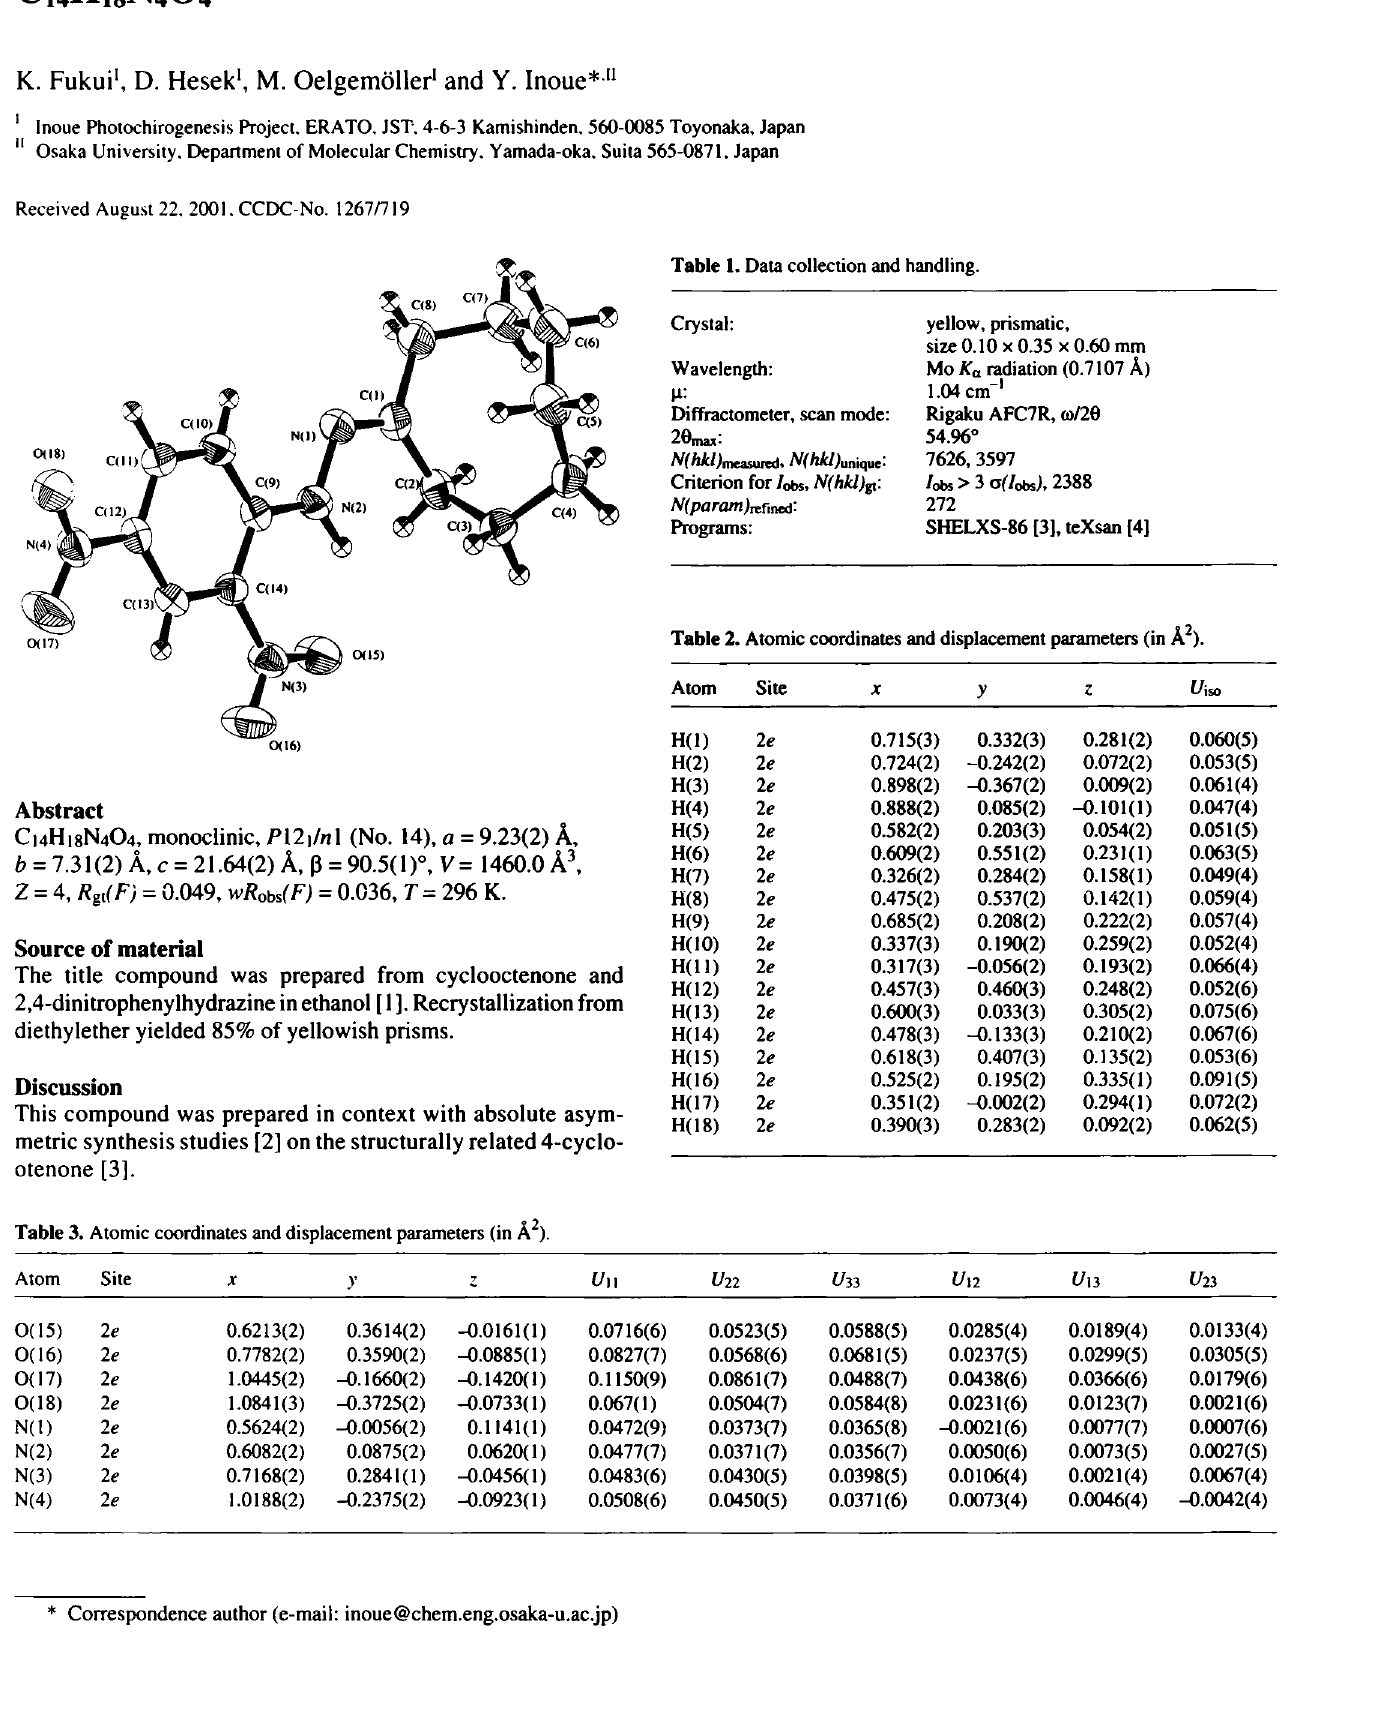
Table 1. Data collection and handling.